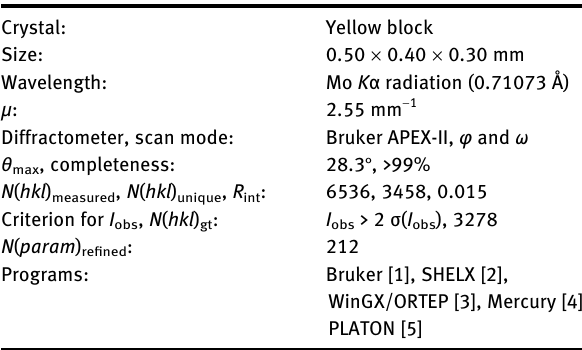
Table  : Data collection and handling.